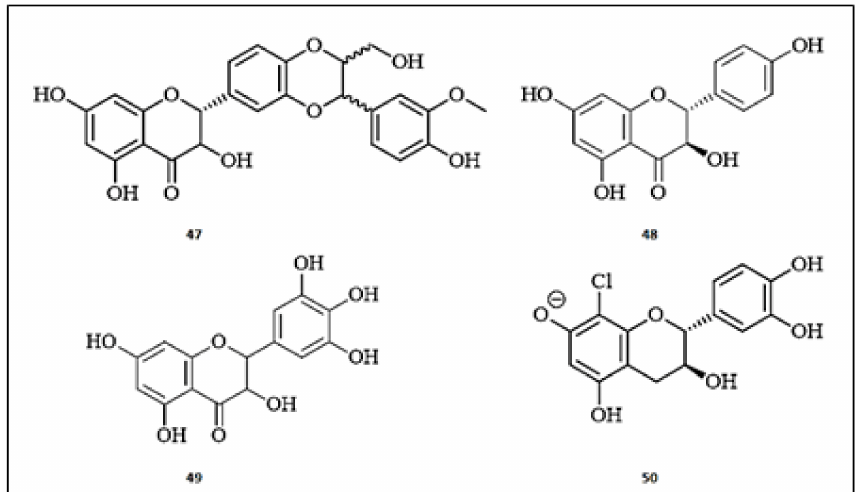
Figure 5. The chemical structures of flavan-3-ols with anti-tyrosinase activity. ( 47 ) Silybin; ( 48 ) (+)-Dihydrokaempferol; ( 49 ) Dihydromyricetin; ( 50 ) ( −